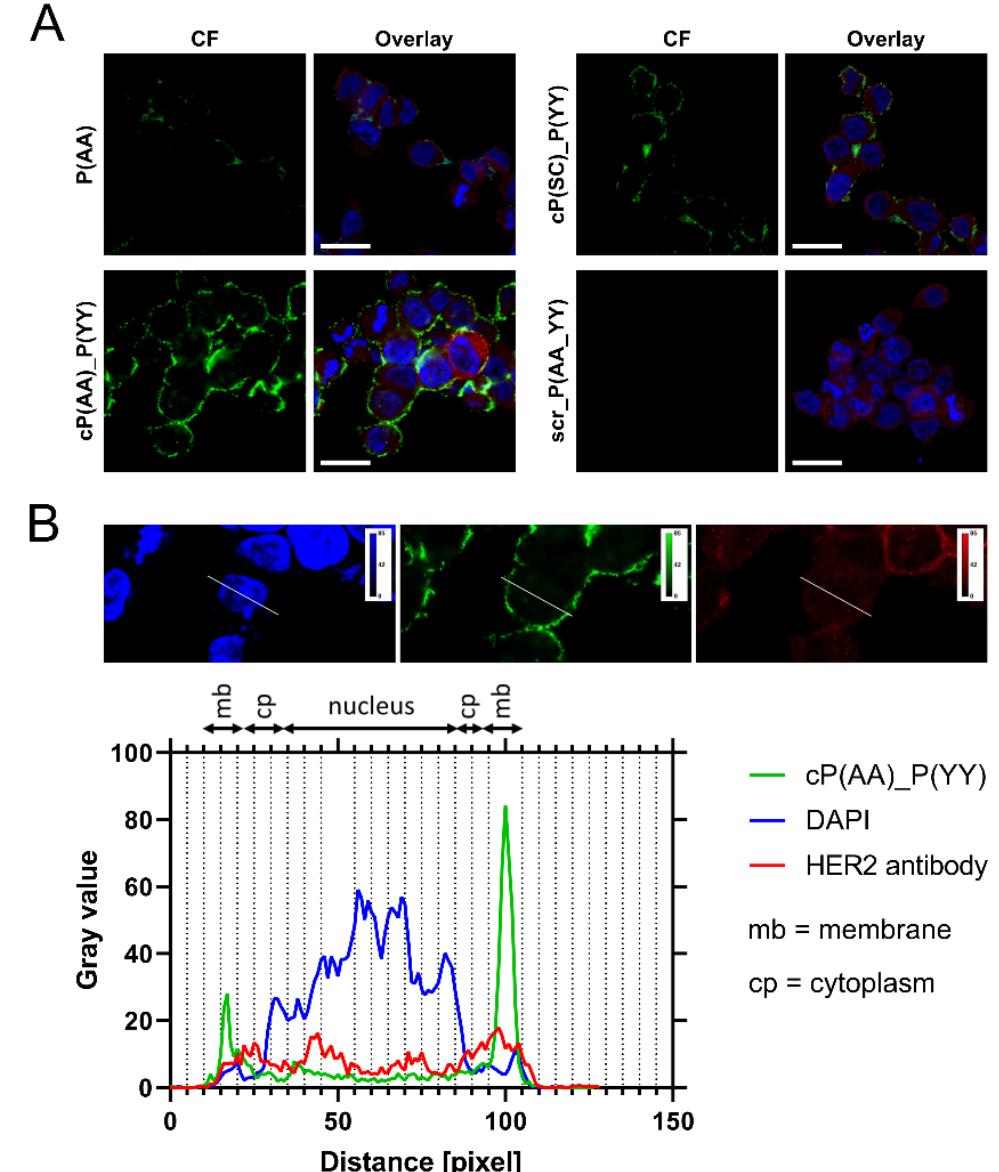
Figure 4. Cellular localization of peptides in MDA-MB-453 cells. ( A ) Cellular uptake of peptides P(AA), cP(AA)_P(YY), cP(SC)_P(YY) and scr_P(AA_YY) studied by confocal microscopy. Cells were incubated with CF-labeled peptides (25 µM) for 90 min (green). HER2 was detected with an anti-HER2 antibody and a TRITC-conjugated secondary antibody (red). Nuclei were stained with 4’6-diamidino-2-phenylindole (DAPI, blue). Zeiss LSM 710 system was used for image acquisition. Scale bars represent 20 µm. ( B ) Line scan of the MDA-MB-453 cells conducted along the white line overlaying the images of the fluorescent channels (top). Green shows the localization of the cP(AA)_P(YY) peptide (below), and blue and red correspond to DAPI and HER2 signals, respectively.